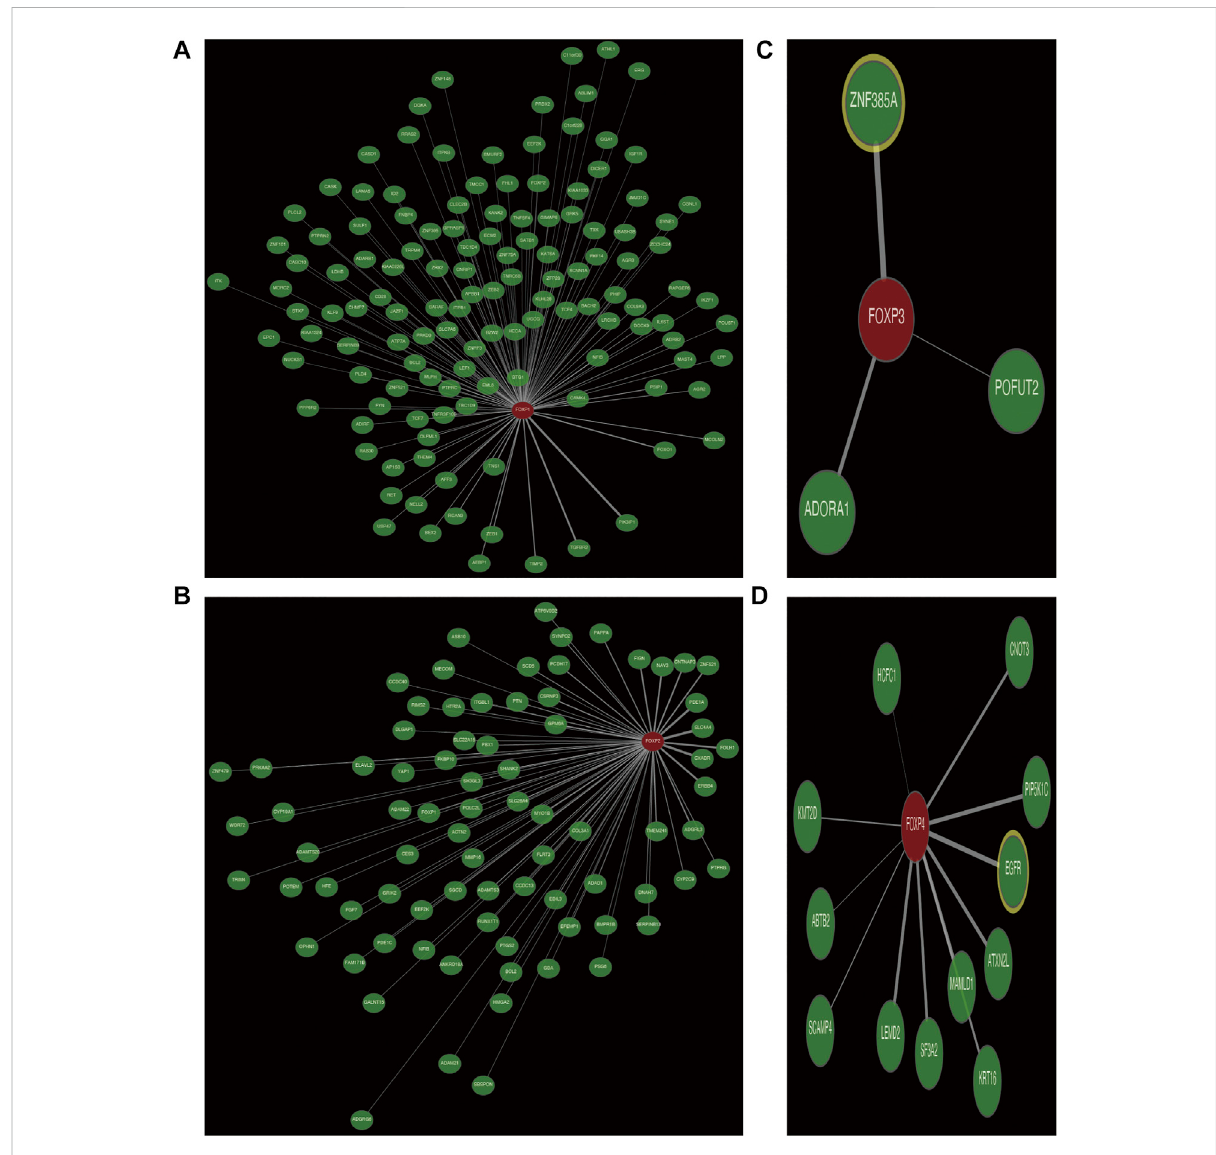
FIGURE 5 The coexpression network of FOXP family. (A) The coexpression network presented the coexpressed genes of FOXP1. (B) The coexpression network presented the coexpressed genes of FOXP2. (C) The coexpression network presented the coexpressed genes of FOXP3. (D) The coexpression network presented the coexpressed genes of